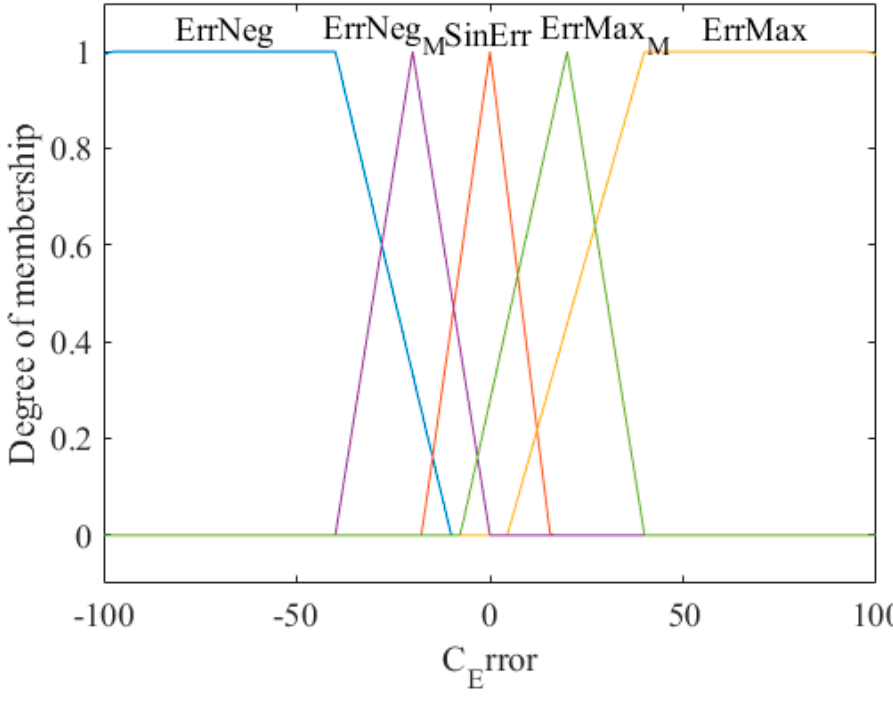
Figure 9. Input 2 for the FLC with step speed reference.